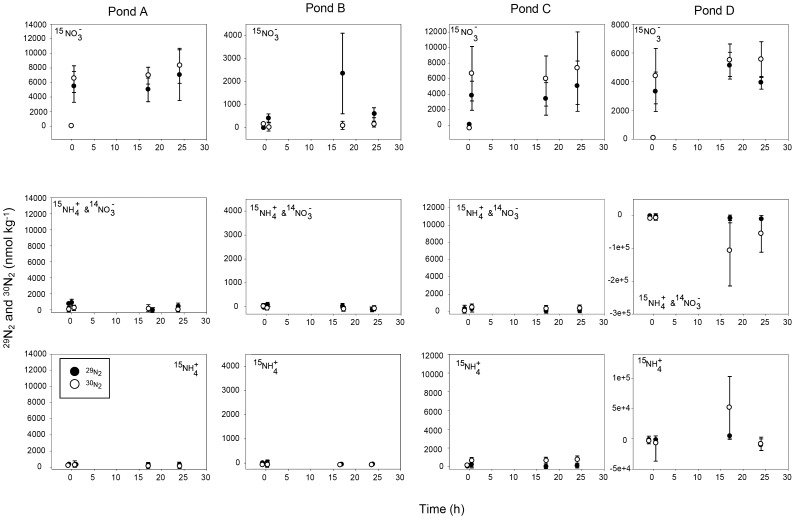
Production of 29N2 (black circles) and 30N2 (white circles) over 24 h.
15N-N2 production in the presence of 15N-NO3
− is represented in row 1, 15N-N2 production in the presence of 15N-NH4
+ and 14N-NO3
− is represented in row 2 and 15N-N2 production in the presence of 15N-NH4
+ is represented in row 3. Column 1 represents 15N-N2 production in sediments collected from pond A, column 2 represents 15N-N2 production in sediments collected from pond B, column 3 represents 15N-N2 production in sediments collected from pond C and column 4 represents 15N-N2 production sediments collected from pond D.